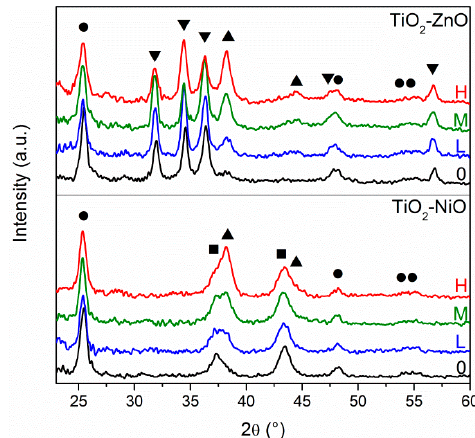
Figure 2. XRD patterns of TiO 2 -NiO and TiO 2 -ZnO series; Au NPs surface coverage in the different samples is highlighted with H (high), M (medium), L (low) and 0 (zero). Predicted diffraction peaks positions for TiO 2 ( ● ), NiO ( ■ ), ZnO ( ▼ ) and Au ( ▲ ) according to the respective ICDD cards are also reported.